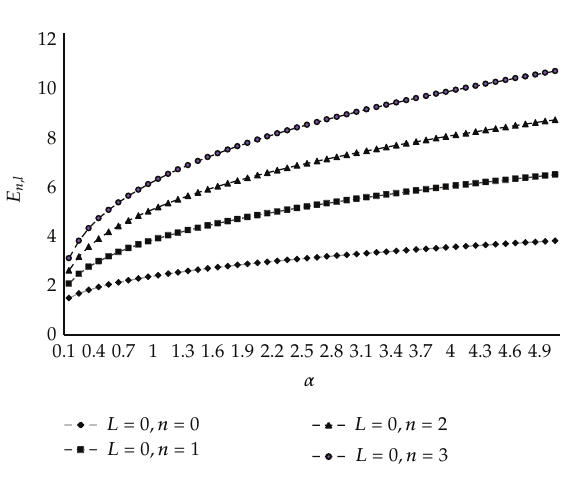
Figure 4: Energy eigenvalues versus α .